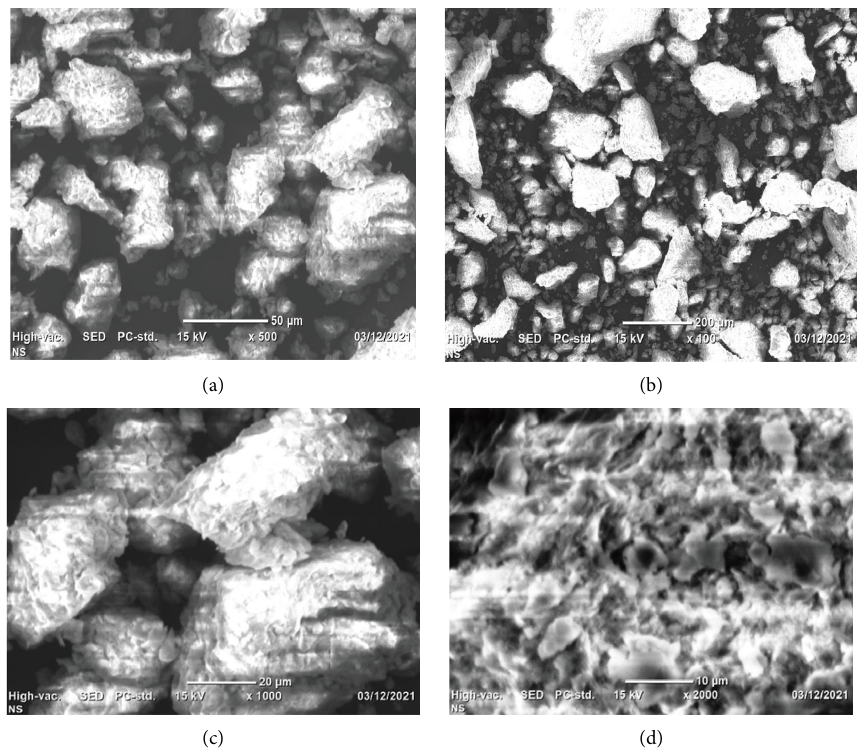
Figure 5: SEM image of natural soil at diferent magnifcation factors. (a) × 100. (b) × 500. (c) × 1000. (d) × 2000.